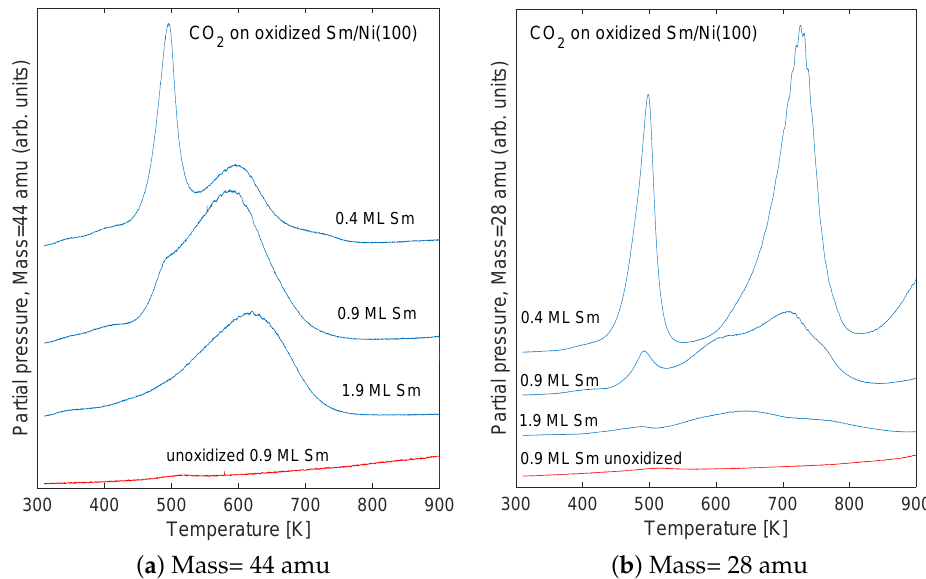
Figure 6. TPD spectra for 1L CO 2 adsorbed on oxidized (top 3 spectra) and pure non-oxidized (bottom spectrum) Sm/Ni(100). The effective Sm coverage is indicated for each